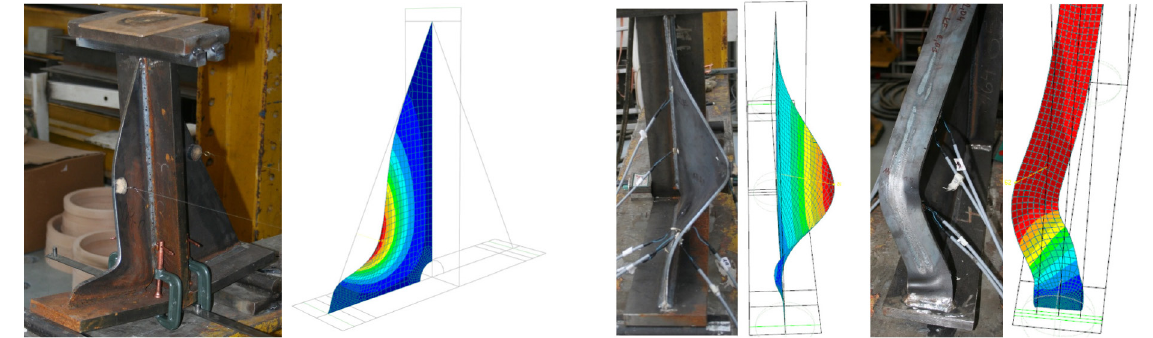
Fig. 16. Experimental and numerical deflection of specimens A, B and D after failure